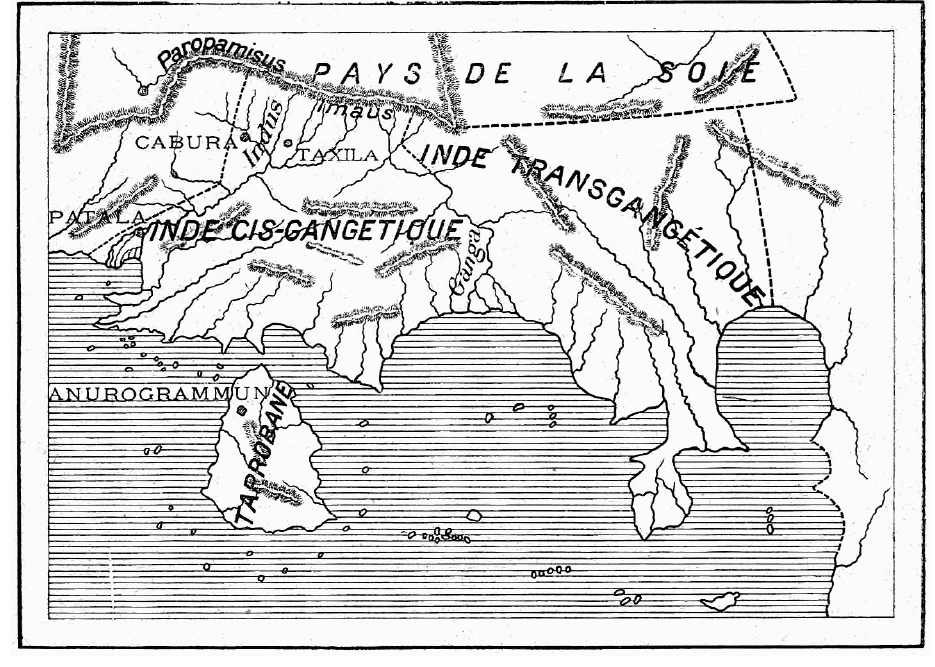
Elisée Reclus 1905: